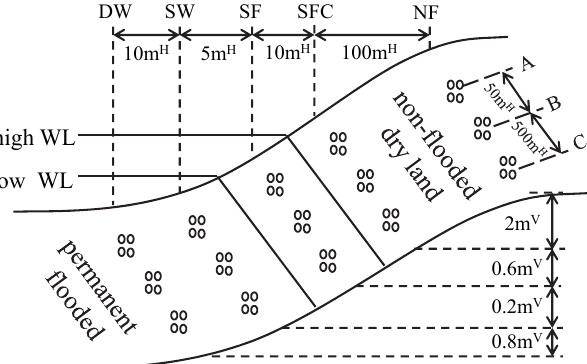
Figure 1. Experimental design. WL: water level. The difference be- tween high WL and low WL was caused by summer flooding. m H indicates height (metres) in the horizontal; m V indicates metres in the vertical. The sites are grouped at different heights as follows. DW: deep water site; SW: shallow water site; SF: seasonally flooded site; SFC: “control site” for the seasonally flooded site, which had similar vegetation and soil moisture as site SF before it was flooded; NF: non-flooded site, which flooded once per several years and not flooded in the sampling year. A, B and C denote samples from dif- ferent vegetation types within each height band; for species details see Table 1. There were 15 plots in total, four replicates in each plot, repeatedly sampled six times in the year to cover different seasons and covering the transition in and out of the flooding season. Also to capture diurnal variation, plots were repeatedly sampled seven times per day. For more details on water depth and other environ- mental parameters, see Figs. 2 and